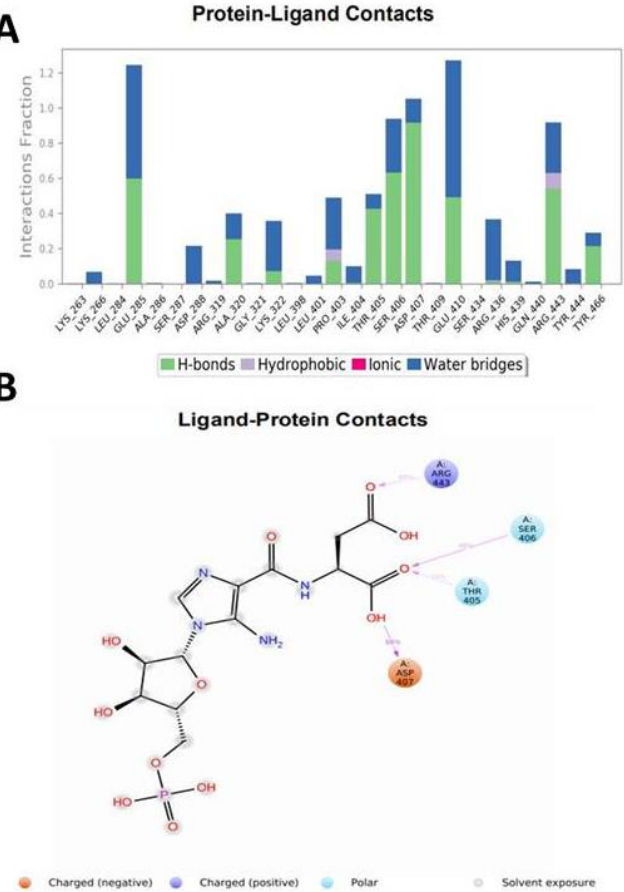
Figure 4. SAICAR shows specific contacts within the activation site of PKM2. ( A ) PKM2 and SAICAR interaction plot on the interaction between amino acid residues and ligand remained during 10 ns simulation. On the Y-axis, the interaction fraction shows the time of established interaction between key amino acid and ligand through different types of bonds such as hydrogen bonds, hydrophobic, ionic, and water bridges. ( B ) Schematic diagram on the interaction of the ligand with amino acid residues, which has remained for more than 30% of interaction time of the simulation. Here, various color combinations are used to represent the extent and nature of ligands to enzyme atomic interactions including ionic, hydrophobic, polar, water, and solvent